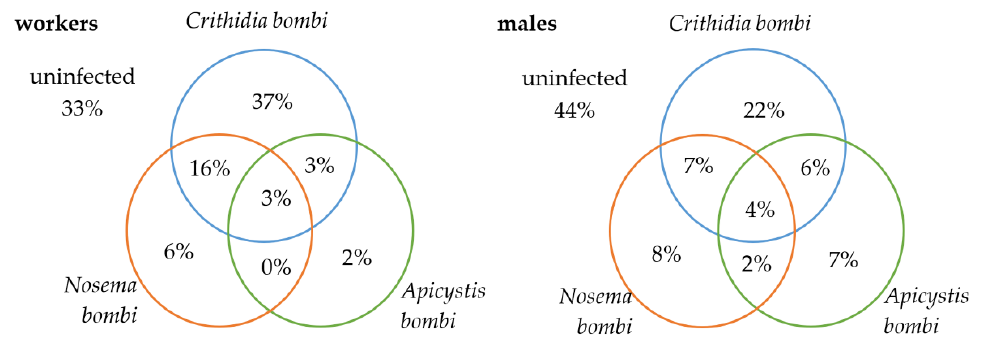
Figure 4. Percentage of individual PCR-positive B. terrestris/lucorum specimens individually and simultaneously infected with pathogens the C. bombi , A. bombi and N. bombi, especially for workers and males.